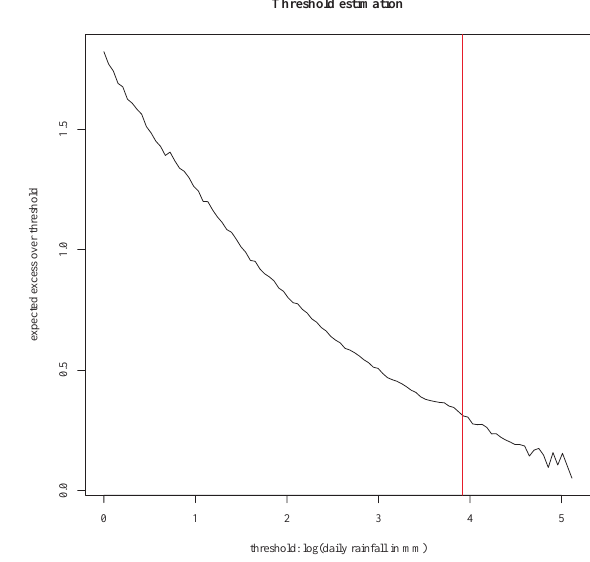
Fig. 1. Barcelona daily rainfall series (1854–2006).